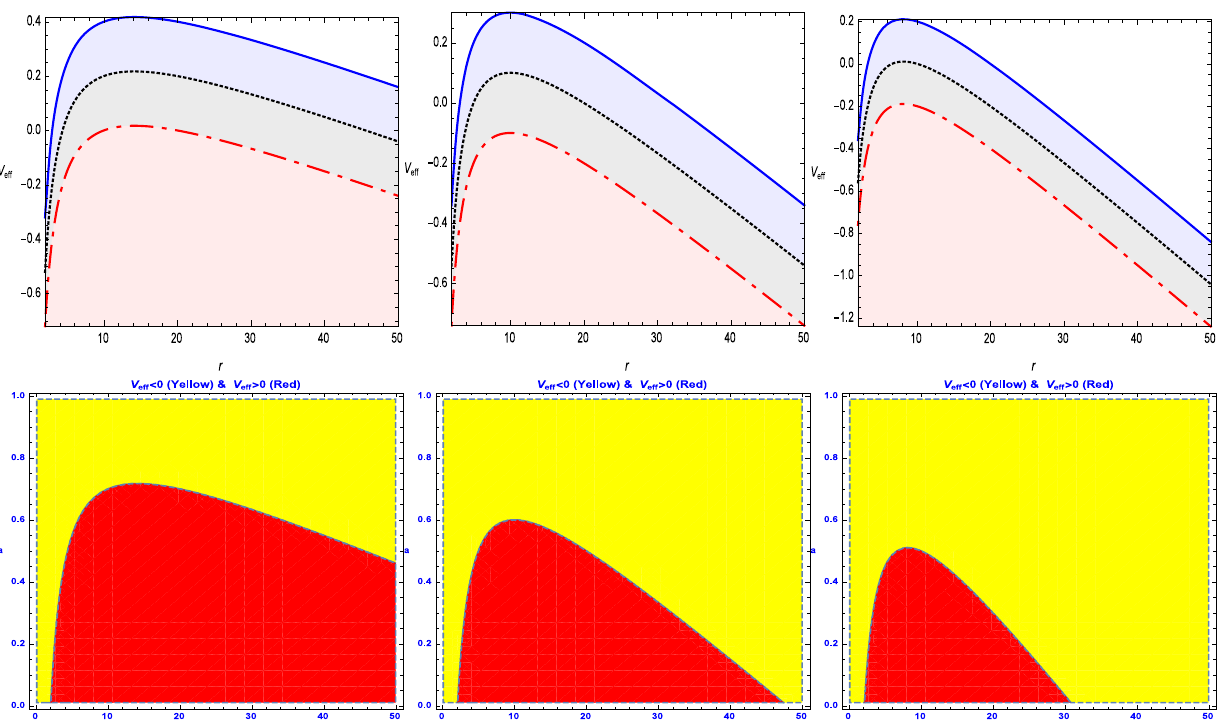
(blue), a = 0 . 5 (black), and a = 0 . 7 (red) with q = 0 . 03. The second rowshows thepositiveandnegativeregionof V ef f ( r ) forthreedifferent values of q = 0 . 01 (left panel), q = 0 . 02 (middle panel), and q = 0 . 03 (right